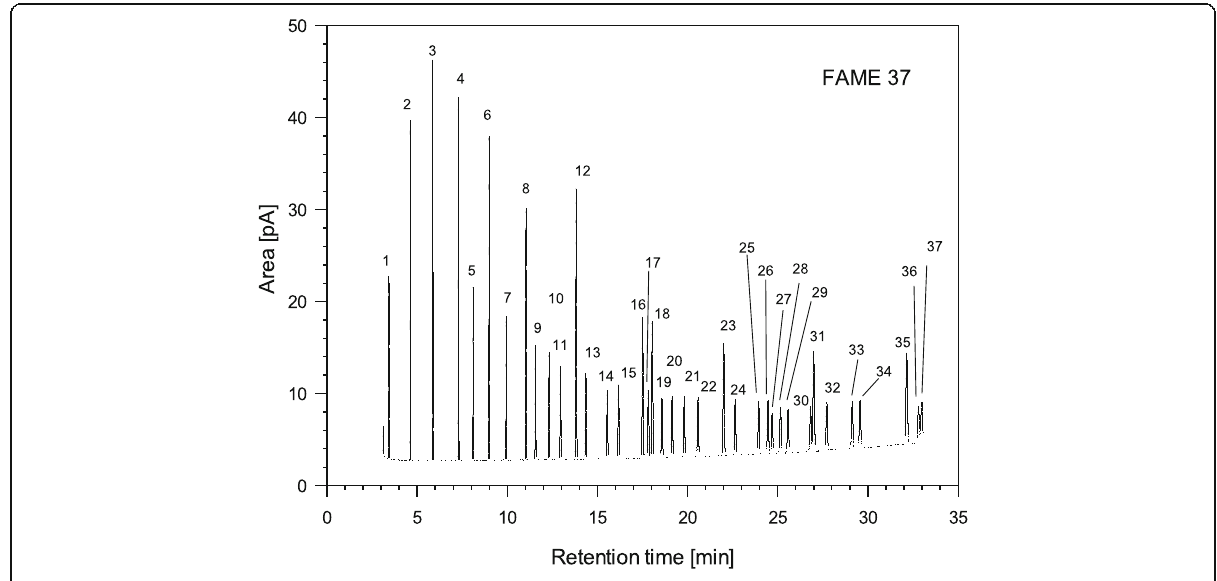
Fig. 1 GC-FID chromatogram of 37 fatty acid methyl esters